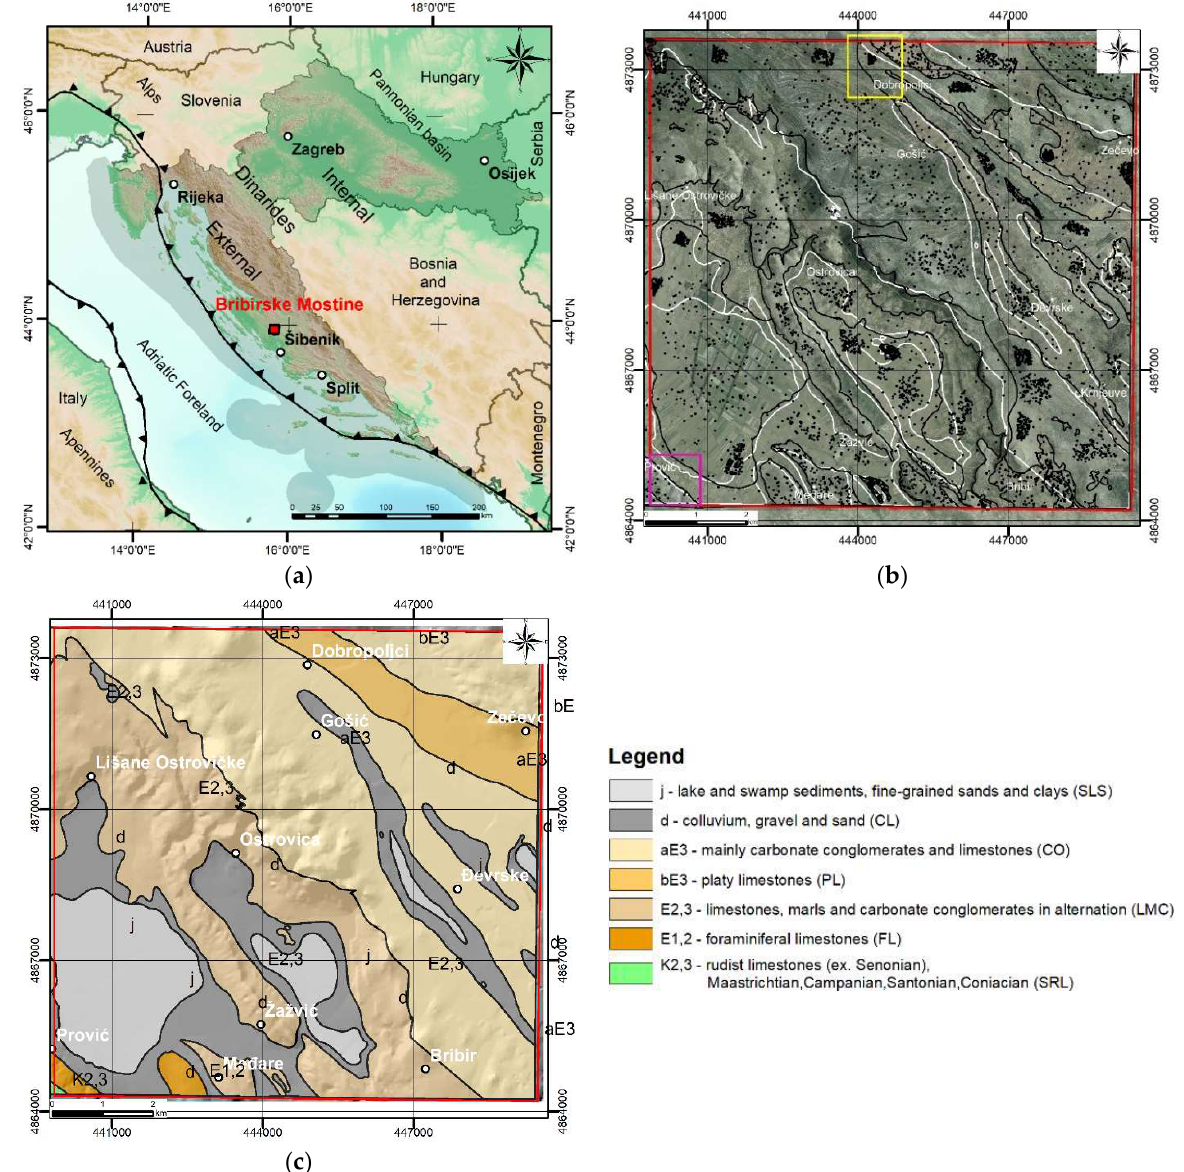
Figure 1. ( a ) Topographic map of the wider region of the eastern Adriatic coast with basic tectonic elements, modified according to [29]; ( b ) digital orthophoto (DOF) of the study area. White lines are geological boundaries (GBs) according to Figure 1c. GBs represented by black lines are derived by K-means and the DOF. Black dots are input points for RF classification. Magenta rectangle represents the Subset 1 site. Yellow rectangle represents the Subset 2 site; ( c ) field geological map of the OGK SFRJ, sheet Bribirske Mostine. Red rectangles in Figure 1b,c are areas in which satellite images were processed.